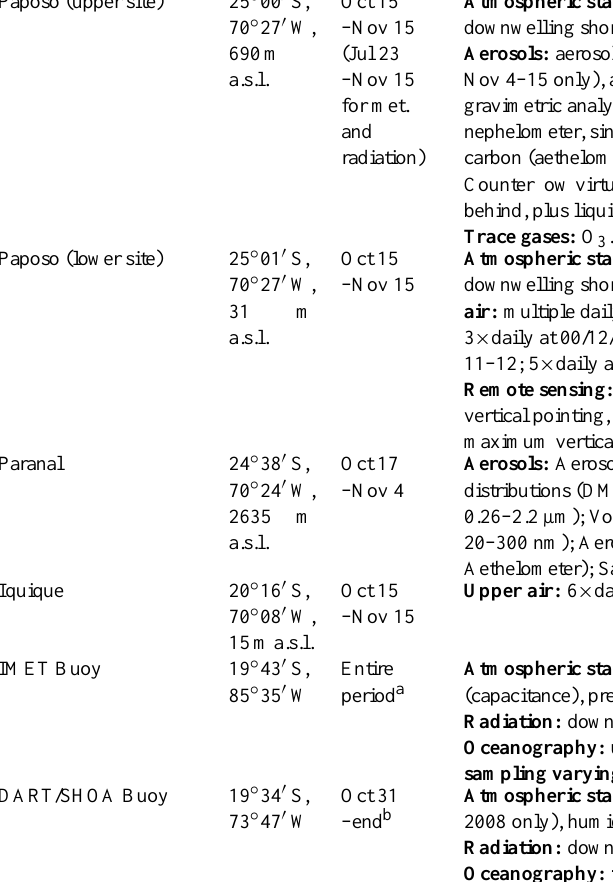
Table 5. Details of the surface sites used in VOCALS-REx. Atmospheric state: temperature, humidity, winds, pressure (weather station), Paposo (upper site) downwelling shortwave and net (LW+SW) radiation (July 23–Nov